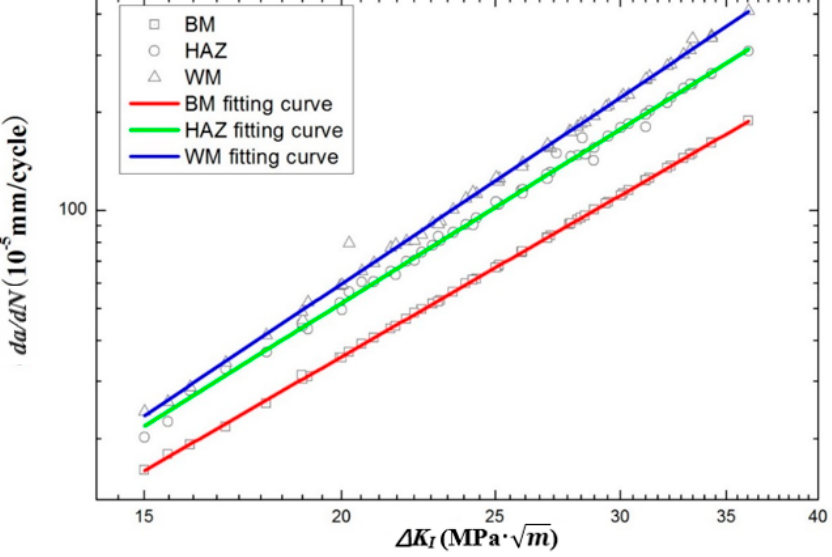
Figure 6. The Paris curves in BM, HAZ and WM specimens.